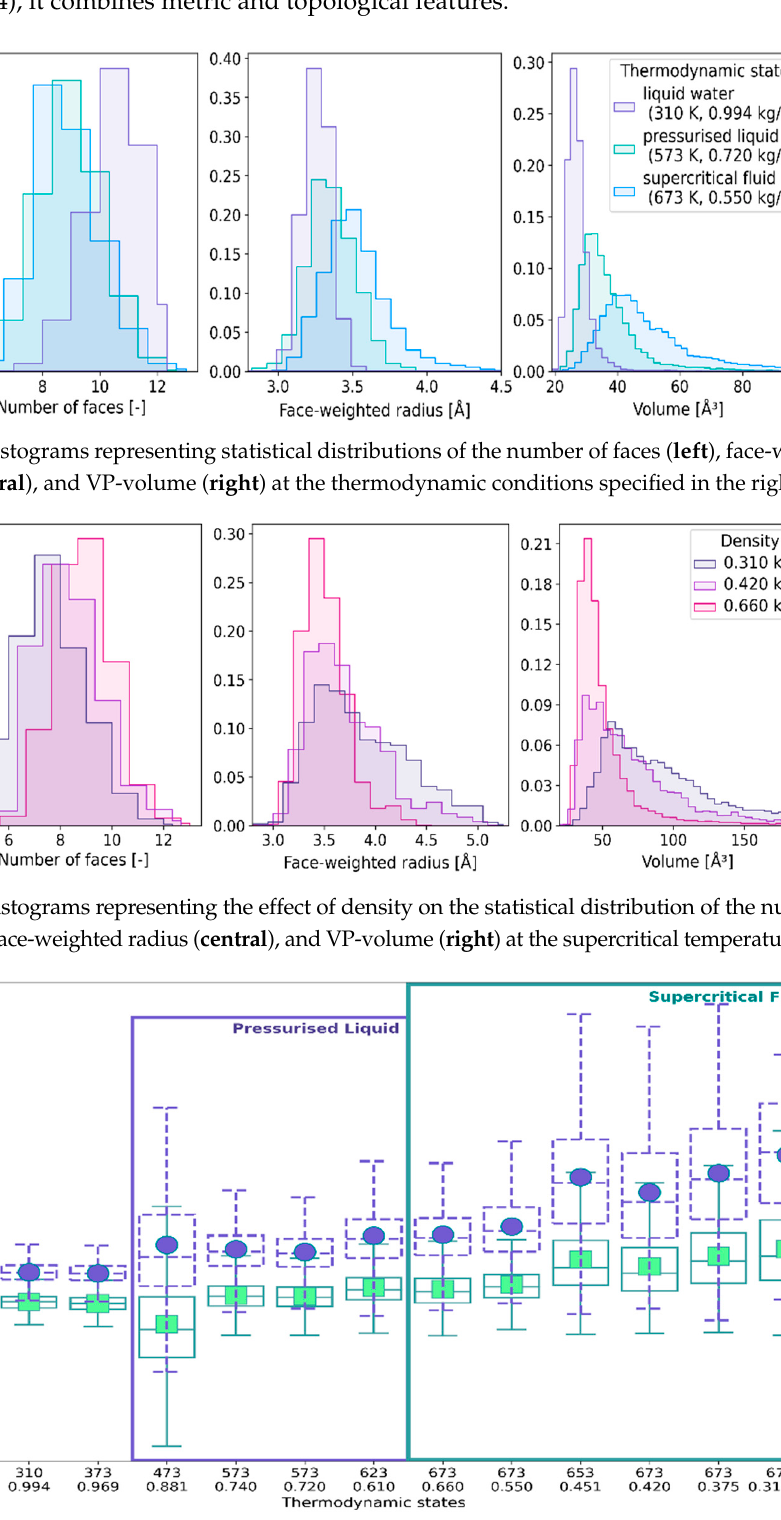
Figure 4. Histograms representing statistical distributions of the number of faces (left), face- weighted radius (central), and VP-volume (right) at the thermodynamic conditions specified in the right panel.